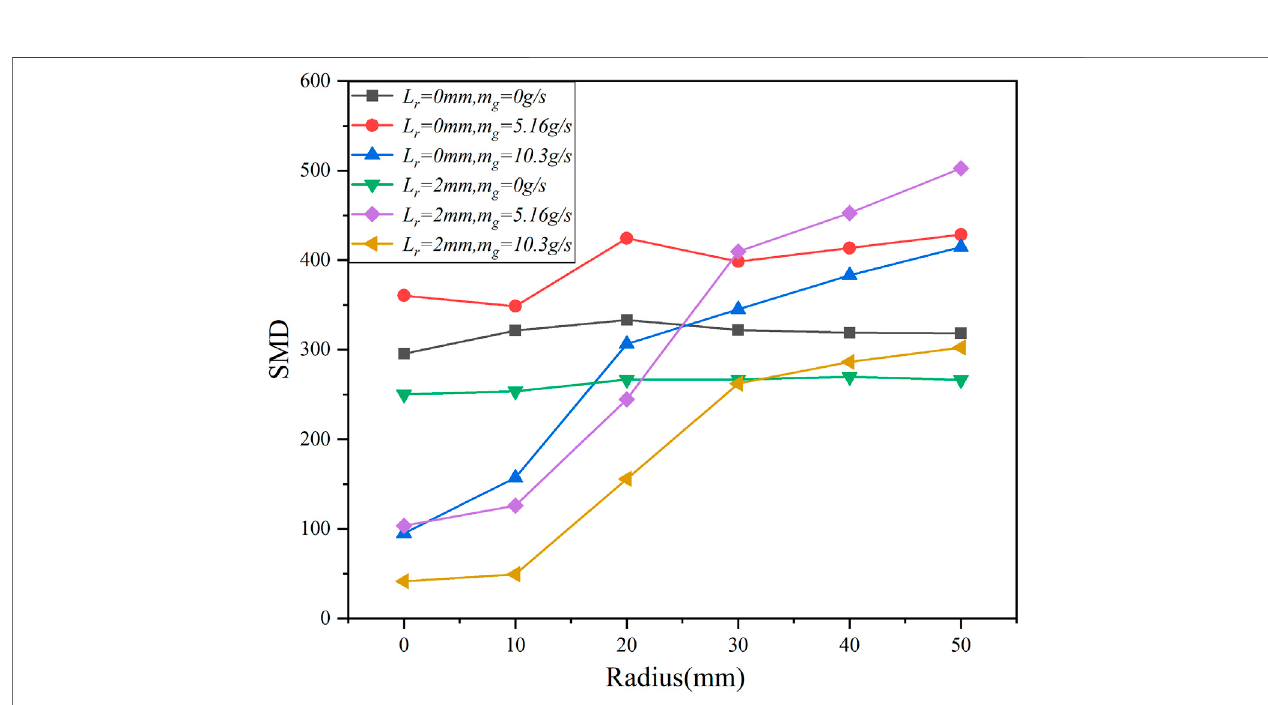
FIGURE 9 | Radial distribution of SMD with different recess